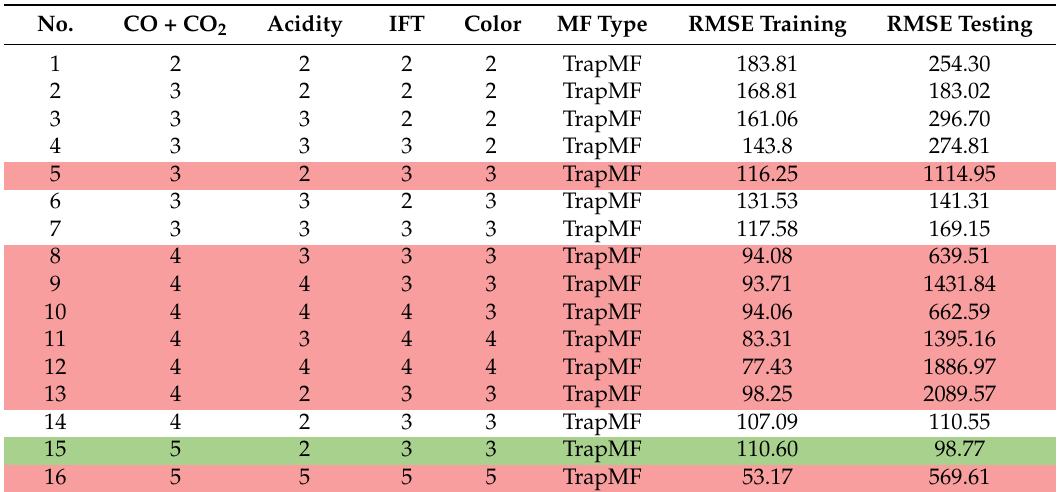
Table 8. Various combinations of membership function (MF) numbers.